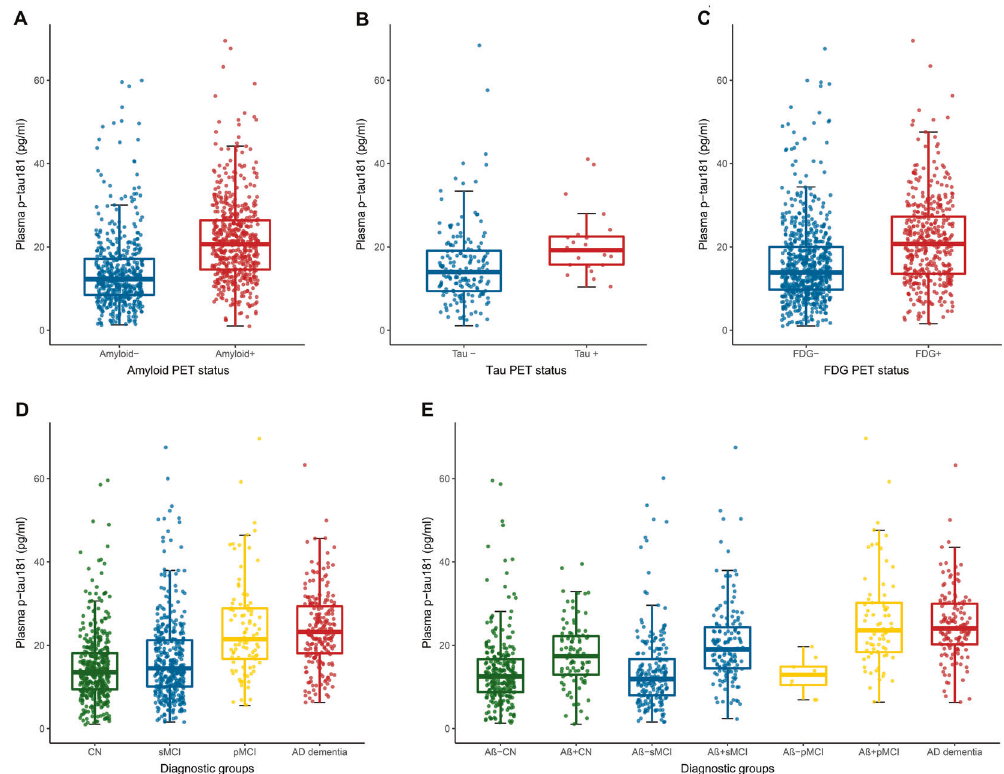
Fig. 1 Plasma p-tau181 plots for PET and clinical classi fi cation groups. Box plots of plasma p-tau181 concentration between amyloid PET groups ( A ), tau PET groups ( B ), FDG PET groups ( C ), clinical diagnostic groups ( D ), or clinical classi fi cation combined with A β status ( E ). Raw data are presented on the box-and-whisker plot background. The middle line represents the median, and the upper and lower lines represent the fi rst and third quartiles, respectively. Patients with mild cognitive impairment were excluded if they had a follow-up time less than 2 years. CN cognitively normal control, sMCI stable mild cognitive impairment, pMCI progressive mild cognitive impairment, AD Alzheimer ’ s disease. Furthermore, plasma p-tau181 correlated signi fi cantly with the status, individuals with A β -PET-positivity had increased plasma cortical amyloid burden in A β -positive subjects (Spearman ρ = p-tau181 compared with those with A β -PET-negativity, separately 0.30, P < 0.0001), while there was no statistical association in in CN (18.0 ± 7.7 vs. 16.7 ± 30.2 pg/ml), sMCI (20.5 ± 9.7 vs. 13.9 ± A β -negative subjects (Spearman ρ = − 0.017, P = 0.72). Separately 9.3 pg/ml), and pMCI (27.5 ± 16.3 vs. 12.6 ± 4.3 pg/ml) subgroups in subjects with or without abnormal tau deposition, no statistical ( P < 0.05; Fig. 1E). correlations were observed between plasma p-tau181 concentra- tion and metaROI fl ortaucipir SUVR (Spearman ρ = 0.11, P = 0.59; Relationships between plasma p-tau181 and PET biomarkers Spearman ρ = 0.14, P = 0.077, respectively). Among individuals As shown in Fig. 2, plasma p-tau181 was positively correlated with with reduced glucose metabolism, plasma p-tau181 had an the summary SUVRs of amyloid fl orbetapir tracer (Spearman ρ = inverse link to metaROI FDG glucose metabolism (Spearman 0.45, P < 0.0001; Fig. 2A) and tau fl ortaucipir tracer (Spearman ρ = ρ = − 0.31, P < 0.0001). This link tended to be slightly weaker in 0.25, P = 0.0003; Fig. 2B). A signi fi cantly negative relationship was those without abnormal brain metabolism (Spearman ρ = − 0.21, P < 0.0001). Fig. 2C).